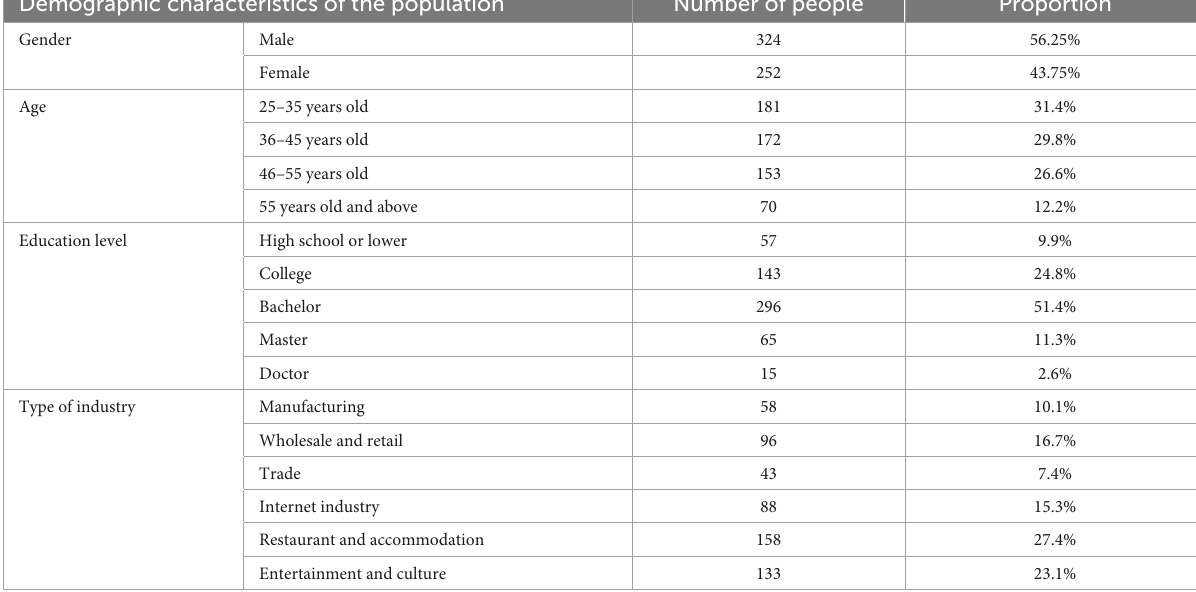
TABLE 1 Sample distribution statistics. Demographic characteristics of the